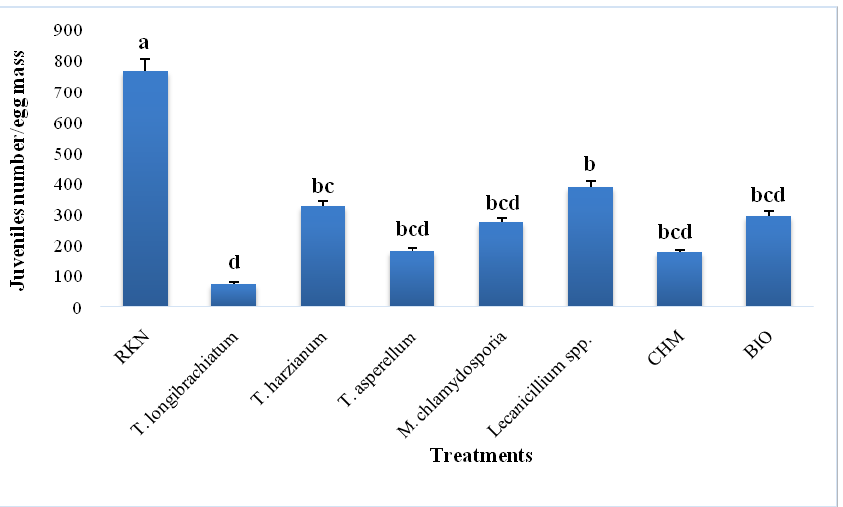
Figure 2. Effect of different treatments on M. javanica fecundity at 60 days post-inoculation (Values are mean of 12 replicates (6 egg masses x 2 repetitions) ± SD; RKN: plants inoculated with M. javanica only; BIO: plants treated with abamectin; CHM: plants treated with ethoprophos; bars sharing the same letter are not significantly different at p ≤ 0.05 to according to Tukey’s multiple range